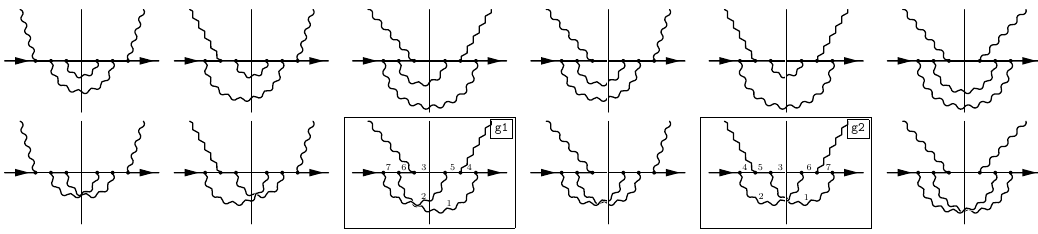
Figure 3. Diagrams contributing to the total cross section of the e − γ → e − γγ